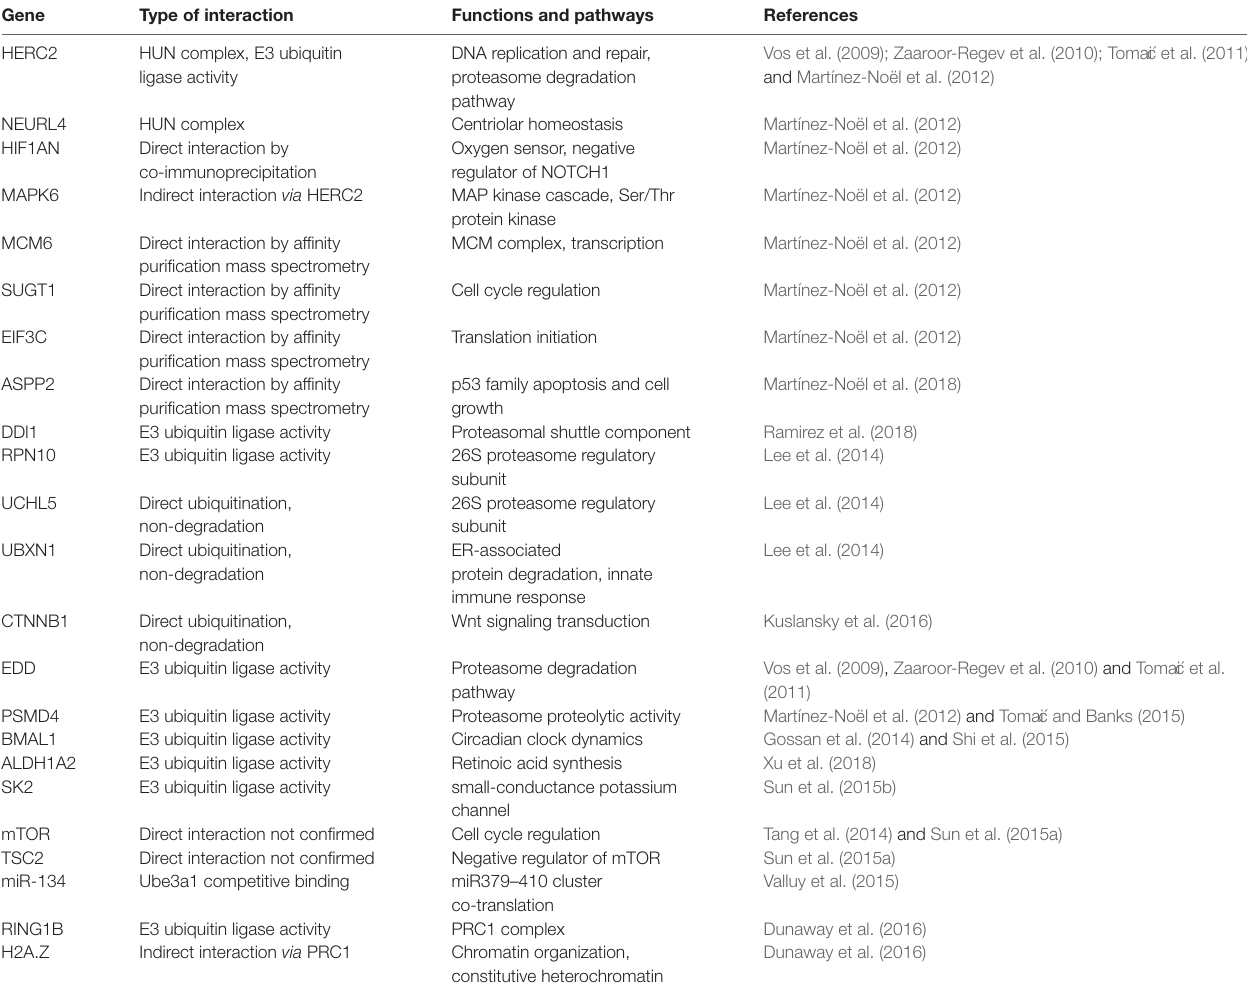
TABLE 1 | Summary of notable gene interactions with UBE3A and associated pathways outlined in this